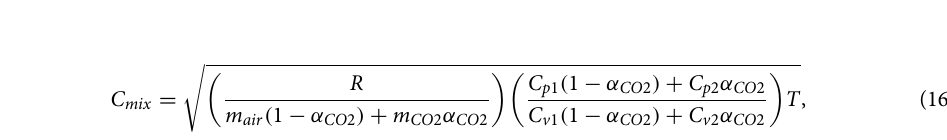
Figure 8. ( A ) sensitivity between air and pure CH 4 samples and transmittance of the resonant mode of air samples, ( B ) FWHM of the resonant mode of air samples and FoM , and ( C ) Q-factor and LoD of the proposed gas sensor at different cross-sections of the second tube of the unit